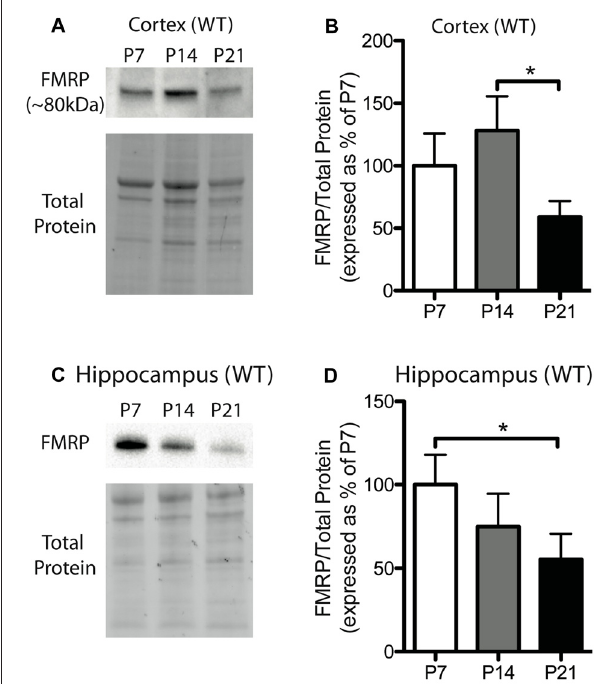
FIGURE 1 | Fragile X mental retardation protein (FMRP) expression is developmentally regulated in the cortex and hippocampus. (A) A representative Western blot showing FMRP ( ∼ 80 kDa) in wild-type (WT) cortical samples (30 µ g of protein per lane) from postnatal day (P) 7, P14